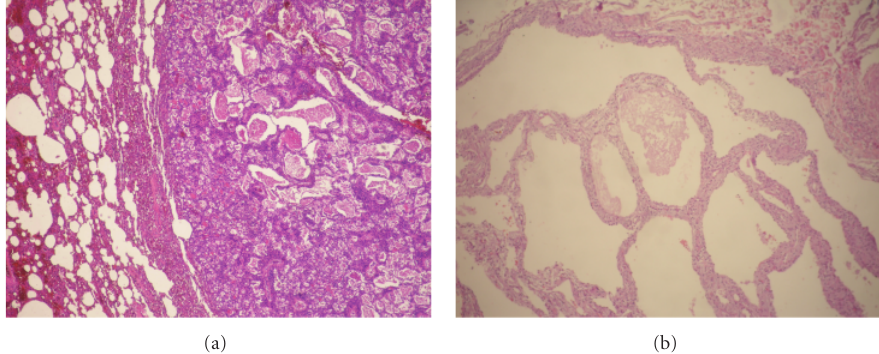
Figure 2: (a) low magnification showing sharp demarcation from the adjacent lung parenchyma and cystic spaces larger in the central area of the tumour. (b) the alveolus-like spaces of this tumor are filled with a finely granular proteinaceous material and thin walls (case 1).